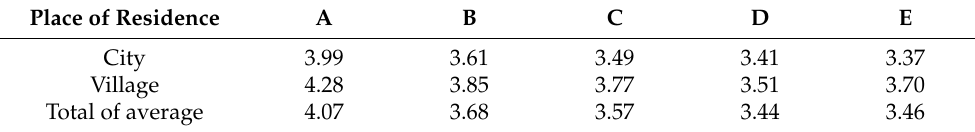
Table 4. Mean values in responses to the question “Necessity 1 to 5”, sorted by place of